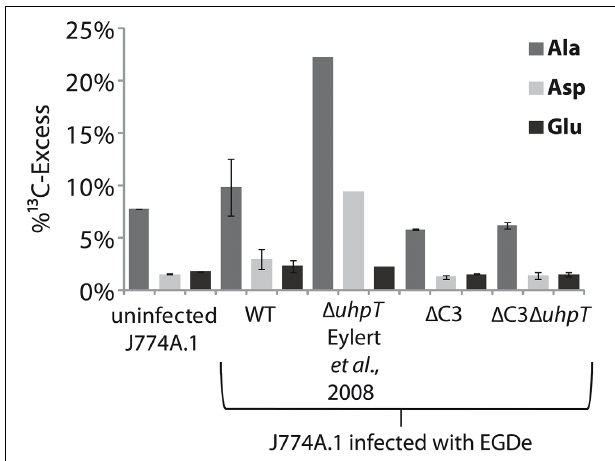
FIGURE 7 | Analysis of protein-derived amino acids from J774A.1 cells labeled with [U- 13 C 6 ]glucose. The columns indicate 13 C-excess (in %) of Ala, Asp, and Glu in experiments with uninfected cells, or cells infected L. monocytogenes EGDe wild-type, (cid:2) C3, (cid:2) uhpT , and (cid:2) C3 (cid:2) uhpT mutants,